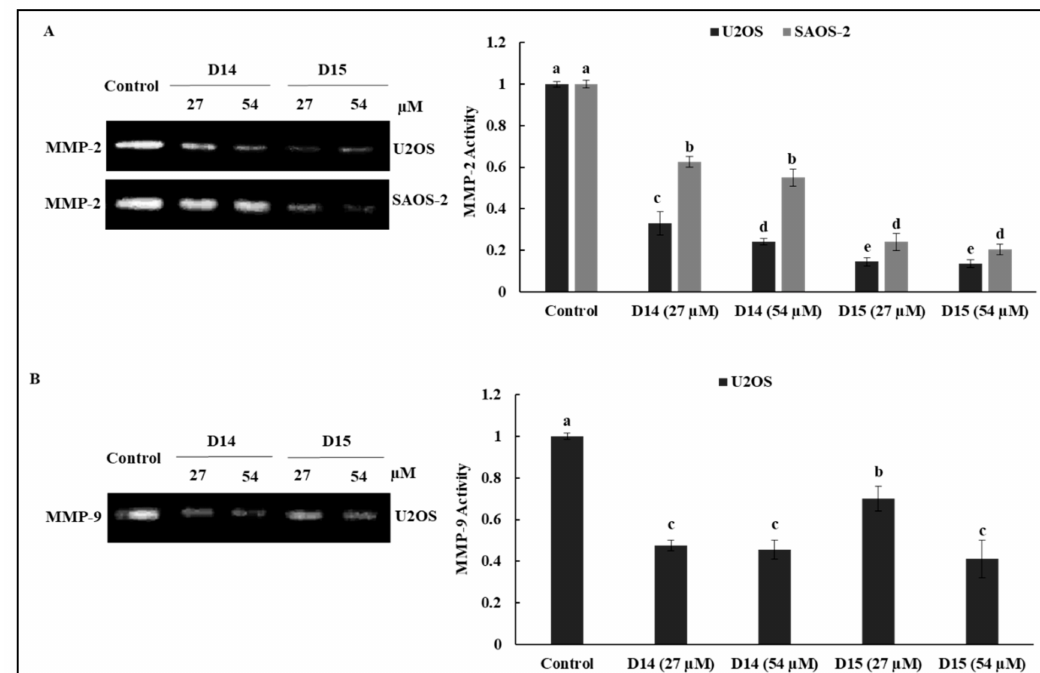
Figure 3. Effects of D14 and D15 on the proteolytic activity of matrix metalloproteinases (MMP)-2 and MMP-9 in osteosarcoma cells. U2OS and SAOS-2 cells were treated with D14 and D15 in serum-free medium at the indicated concentrations for 24 h. Next, the supernatant (conditioned medium) was collected and subjected to gelatin zymography to analyze the activity of secreted MMP-2 ( A ) and MMP-9 ( B ). Quantitative results of three independent experiments are expressed as means ± standard deviation. Means followed by the same letter are not significantly different ( p < 0.05) according to Tukey’s HSD